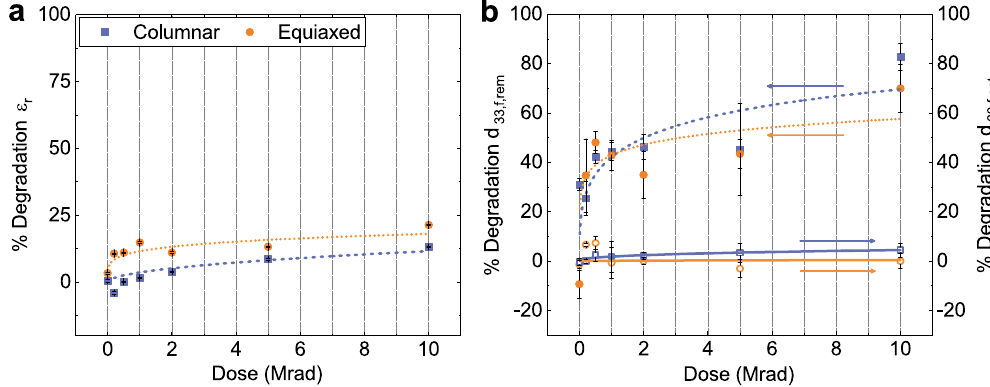
Figure 4. Application of the proposed model (curves) to experimental data from PZT thin films with columnar and equiaxed grain structure. ( a ) Plots of relative, low-field dielectric permittivity, and ( b ) saturation and remanent piezoelectric as a function of radiation dose 62 , and the fitted model to each data set. Error bars show standard error of the sample mean. Fitted parameters are detailed in Table 1.